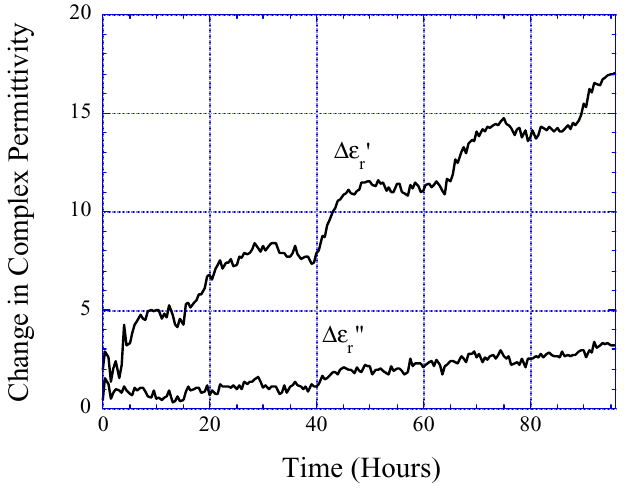
Figure 11. The change in the measured complex permittivity of the beer culture as a function of time, as measured with a LC